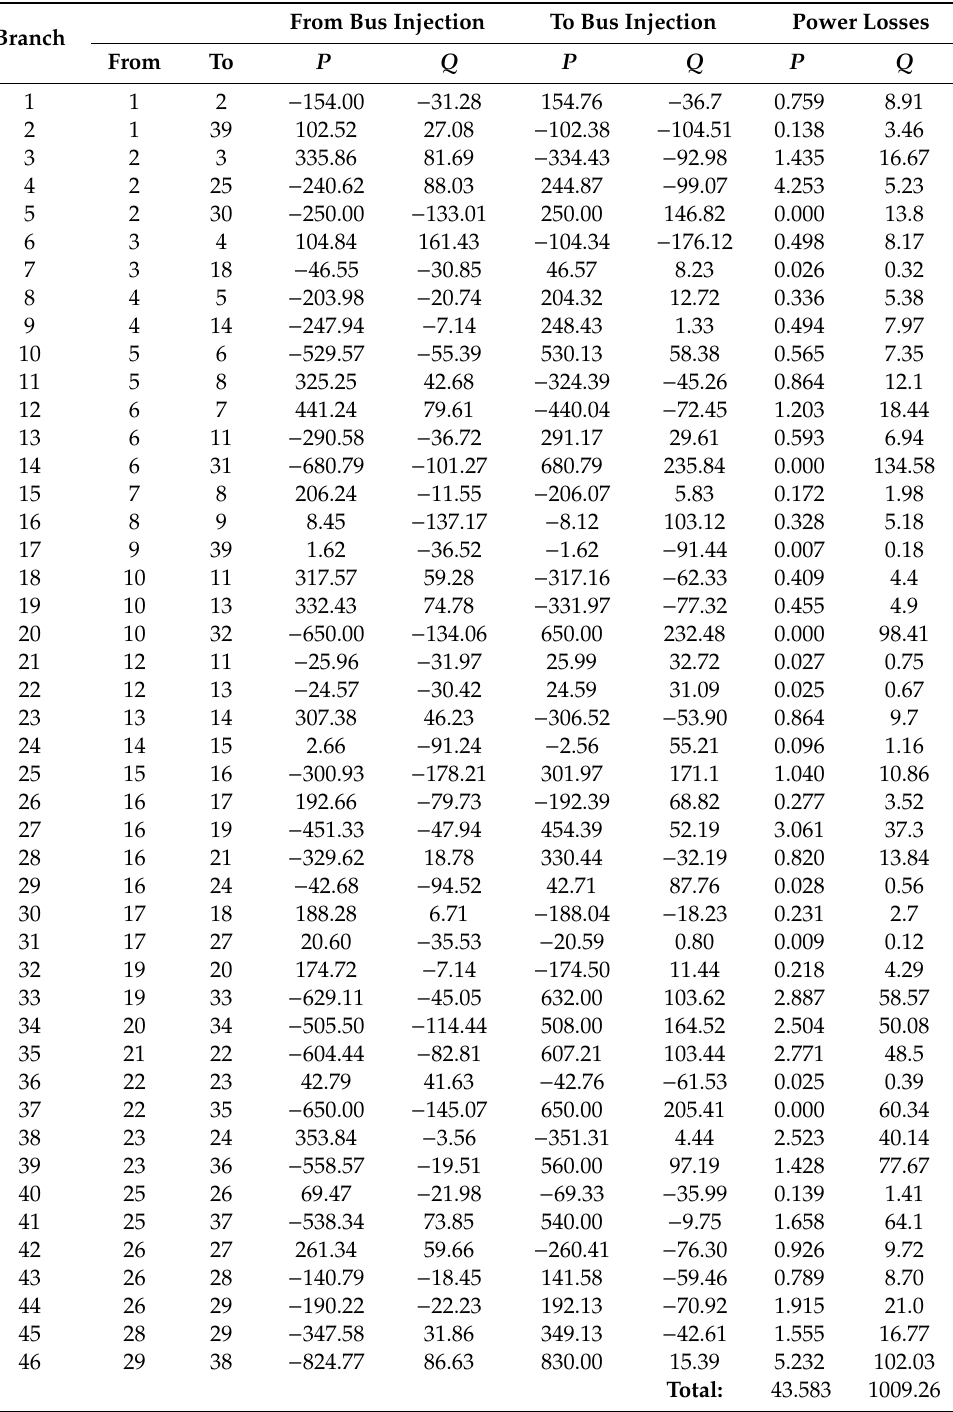
Table A41. Results of Mixed AC / DC PF calculations in Case 7-3. AC branch